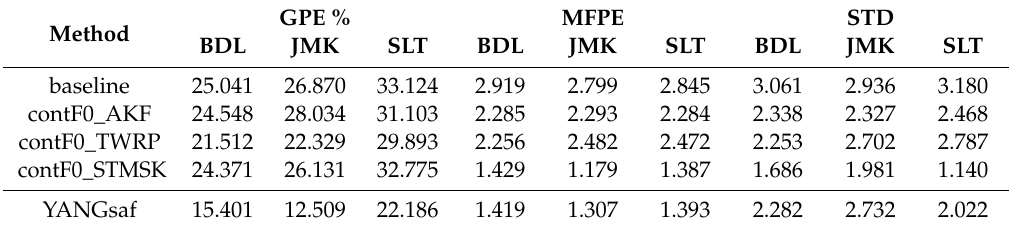
Table 3. Average performance score per each speaker in the presence of pink noise (SNR = 0